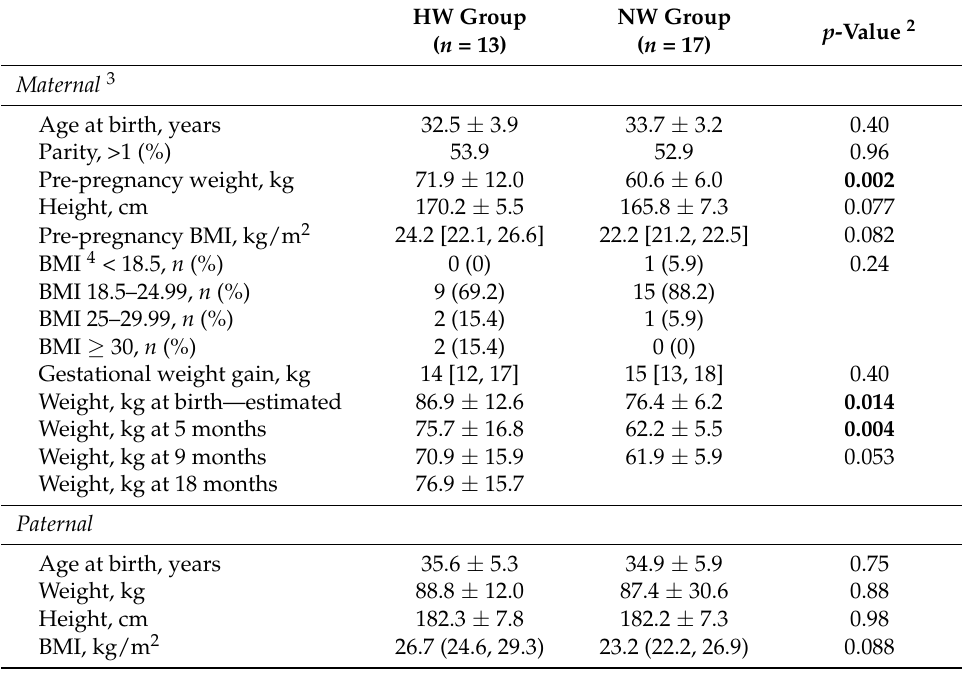
Table 2. Parental characteristics according to the high weight gain and normal weight gain group 1